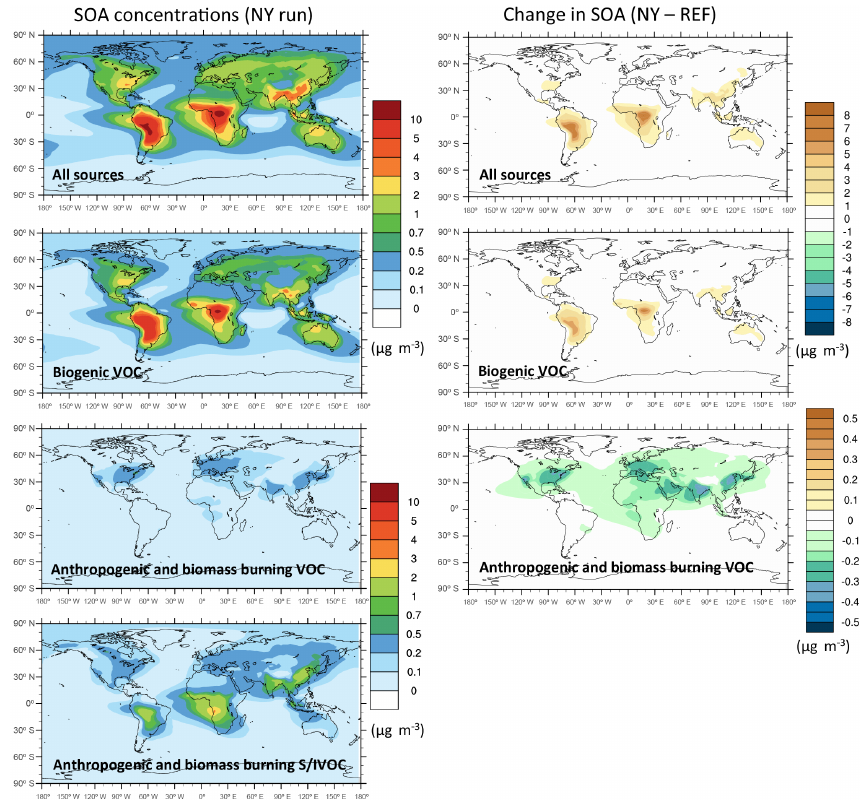
Figure 1. Average concentrations for SOA and its constituents during 2005–2008 as predicted by the GEOS-Chem NY run in the lower troposphere (surface to 5km; left column). Total SOA is separated into SOA from biogenic VOCs, anthropogenic and biomass burning traditional VOCs, and anthropogenic and biomass burning S/IVOC. The NY run is also compared with REF (right